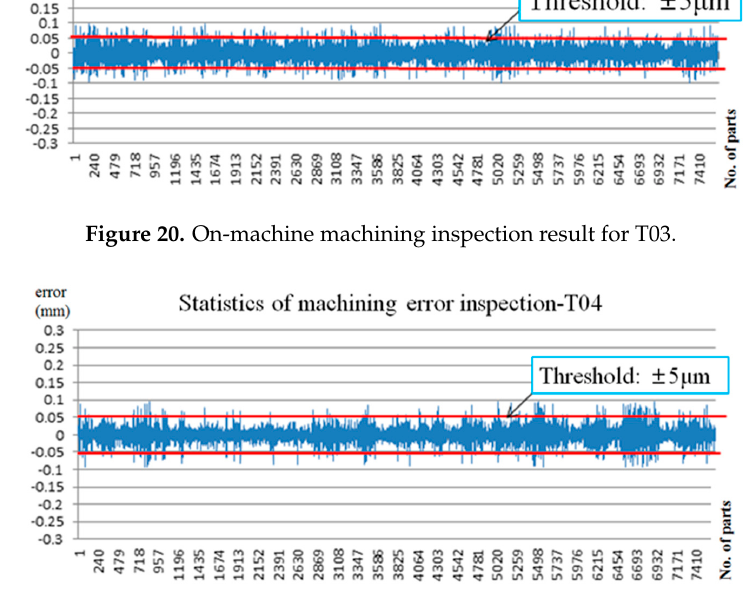
Figure 21. On ‐ machine machining inspection result for T04.